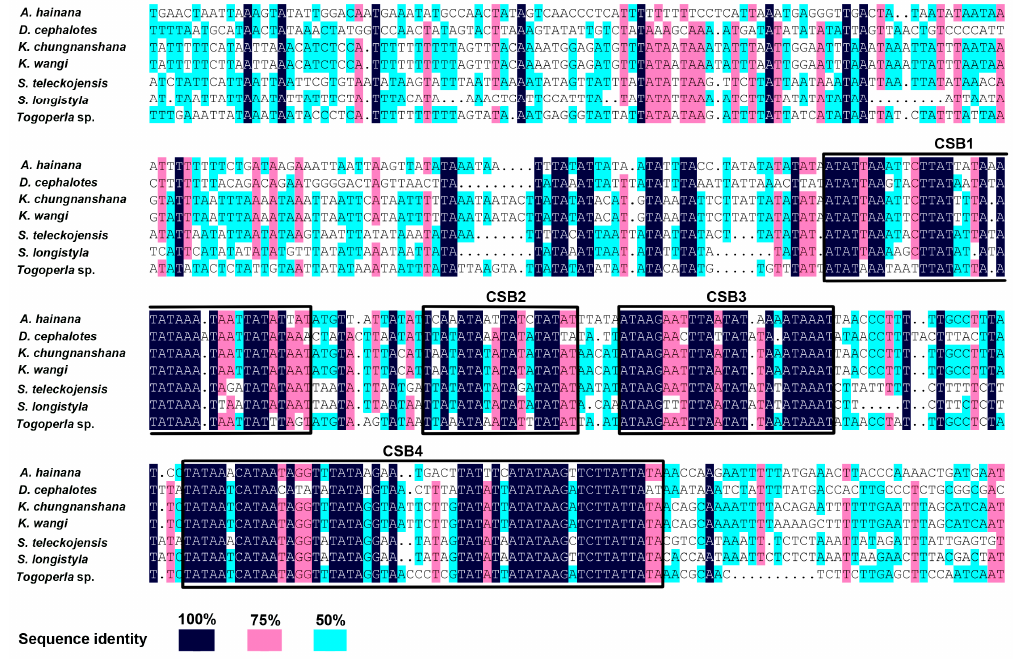
Figure 6. The alignment of conserved structural elements of CRs among stoneflies. Sequence identity among species was indicated by colored boxes. CSB1–4 indicates four conserved sequence blocks in the CRs. Blue color means 100% sequnce identity. Pink color means 75% sequnce identity. Green color means 50% sequnce identity.